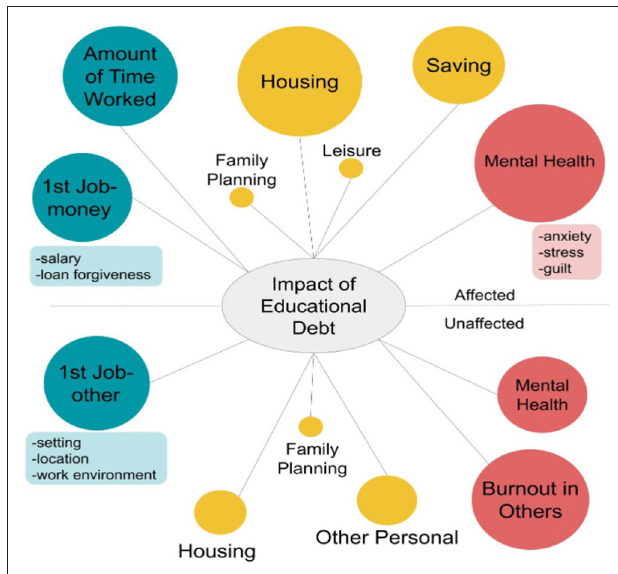
FIGURE 1 | Qualitative themes identified as affected or unaffected by DPT educational debt. The frequency of participants reporting each factor is represented by the size of bubbles, with larger bubbles indicating more